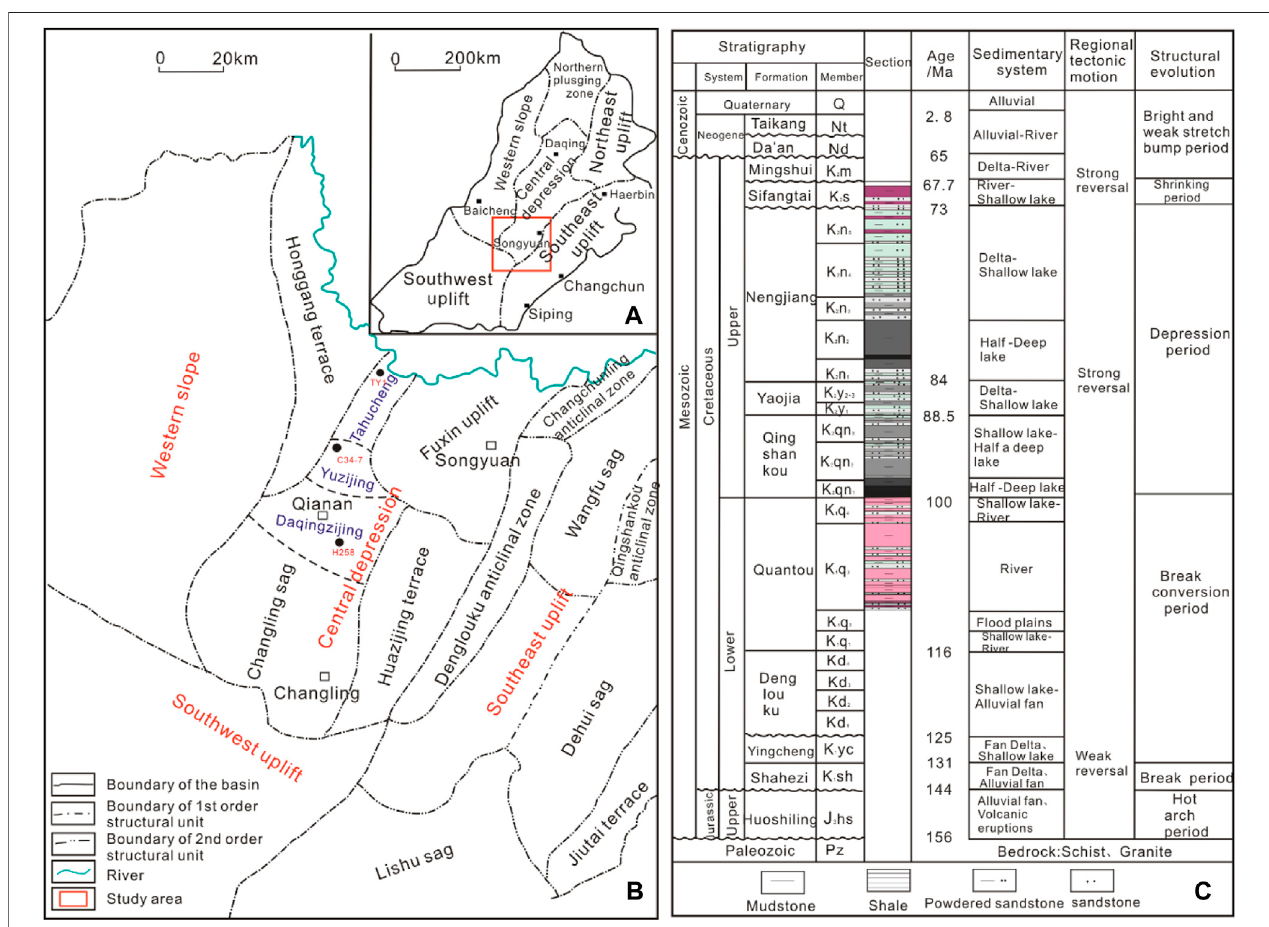
FIGURE1|(A) Simpli fi eddistributionmapofthetectonicunitsintheSongliaoBasin. (B) EnlargedviewofthesouthernpartofthecentraldepressionoftheSongliao Basin. (C) Composite stratigraphic columnar section of the southern part of the Songliao Basin [modi fi ed following Huang et al. (2011)].